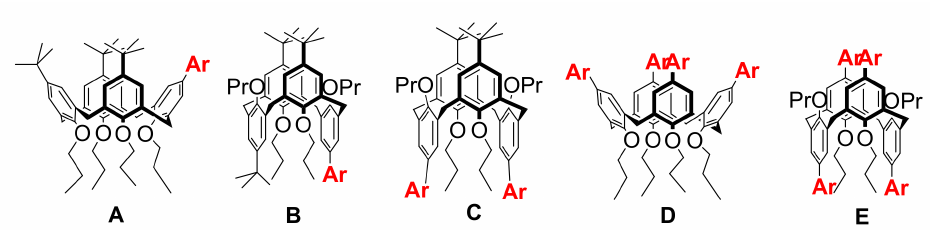
Figure 1. Calix[4]arene ether derivatives; cone ( A ) and 1,3-alternate ( B ) conformers of monoaryl- calix[4]arene tetrapropyl ethers; ( C ) 1,3-alternate conformers of diarylcalix[4]arene tetrapropyl ether; cone ( D ) and 1,3-alternate ( E ) conformers of tetraarylcalix[4]arene tetrapropyl